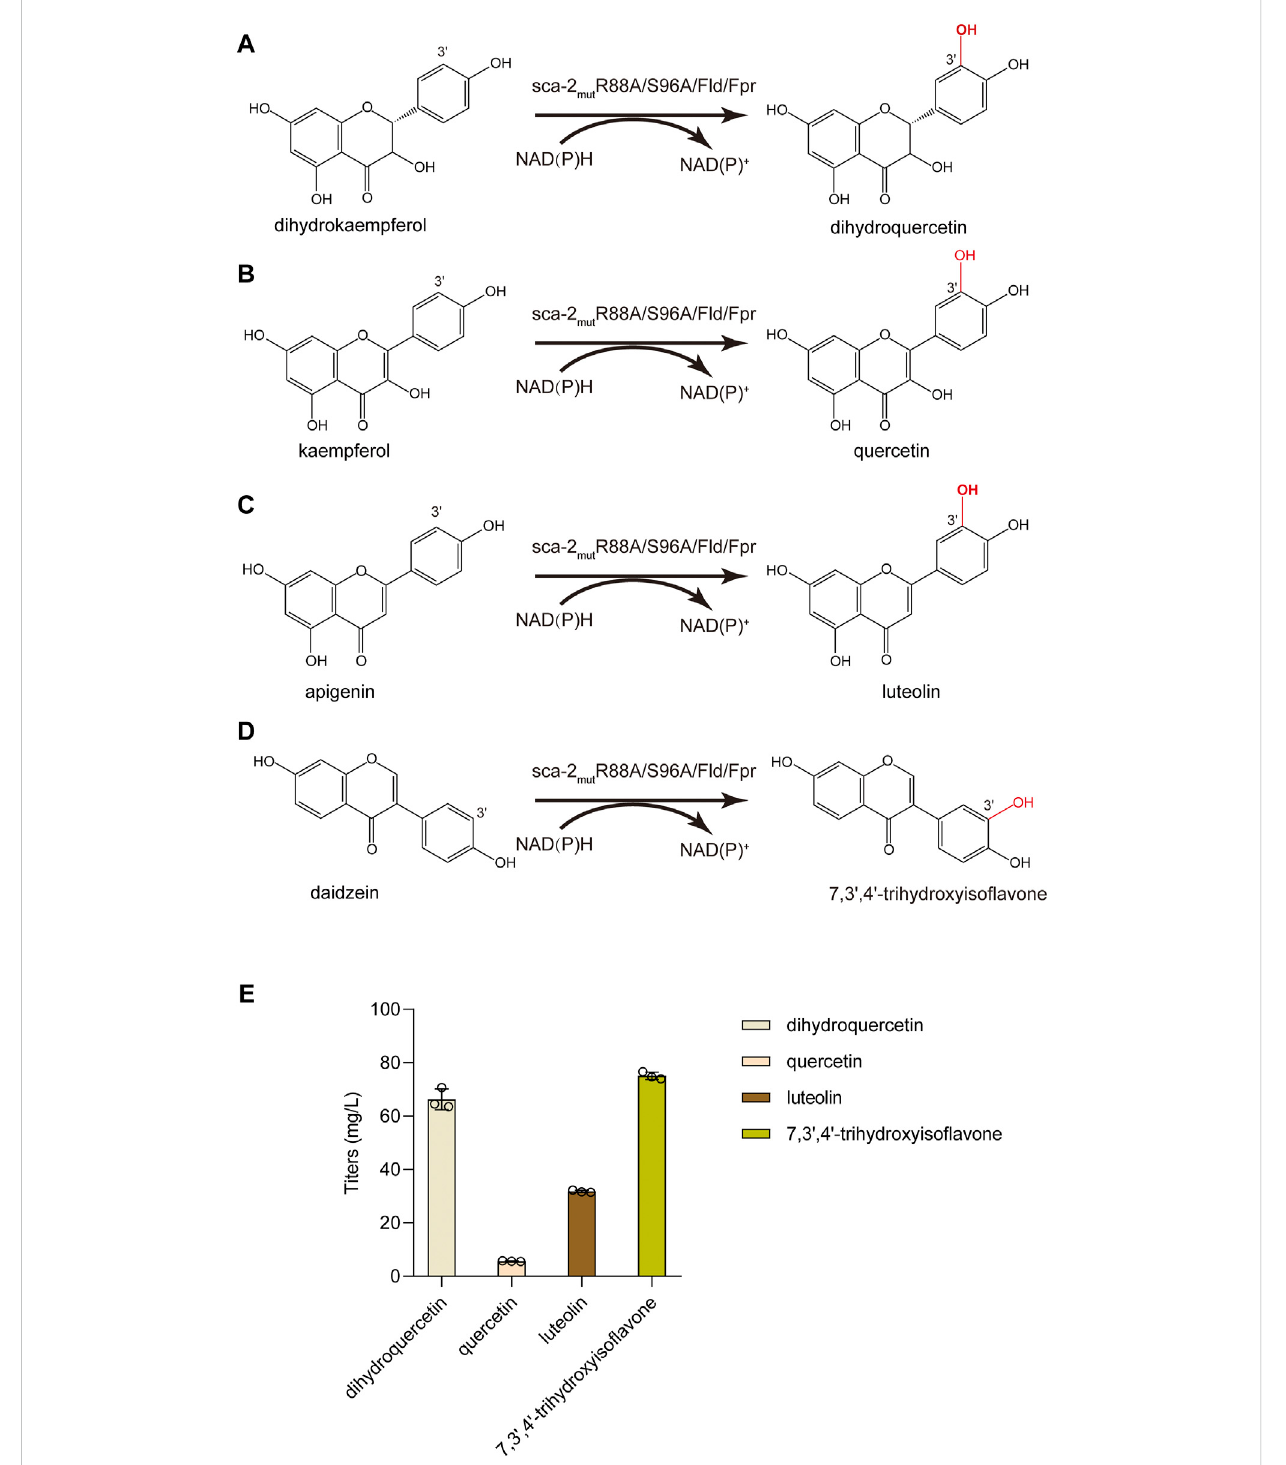
Biocatalytic hydroxylation of different fl avonoids. (A – D) Schematic representation of the enzymatic reactions catalyzed by sca-2 mut R88A/S96A. (E) Titers of dihydroquercetin, quercetin, luteolin, and 7,3 ′ ,4 ′ -trihydroxyiso fl avone produced by the HFLA-19 whole-cell biocatalyst. The data are shown as mean ± SD of three biological